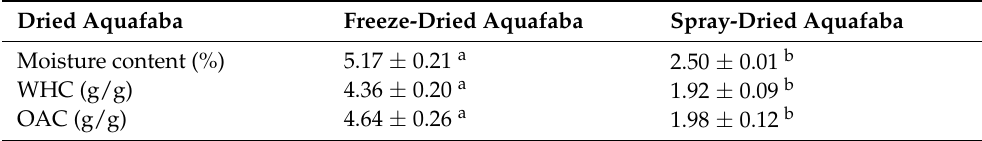
Table 3. Physicochemical properties of freeze-dried and spray-dried aquafaba. Dried Aquafaba Freeze-Dried Aquafaba